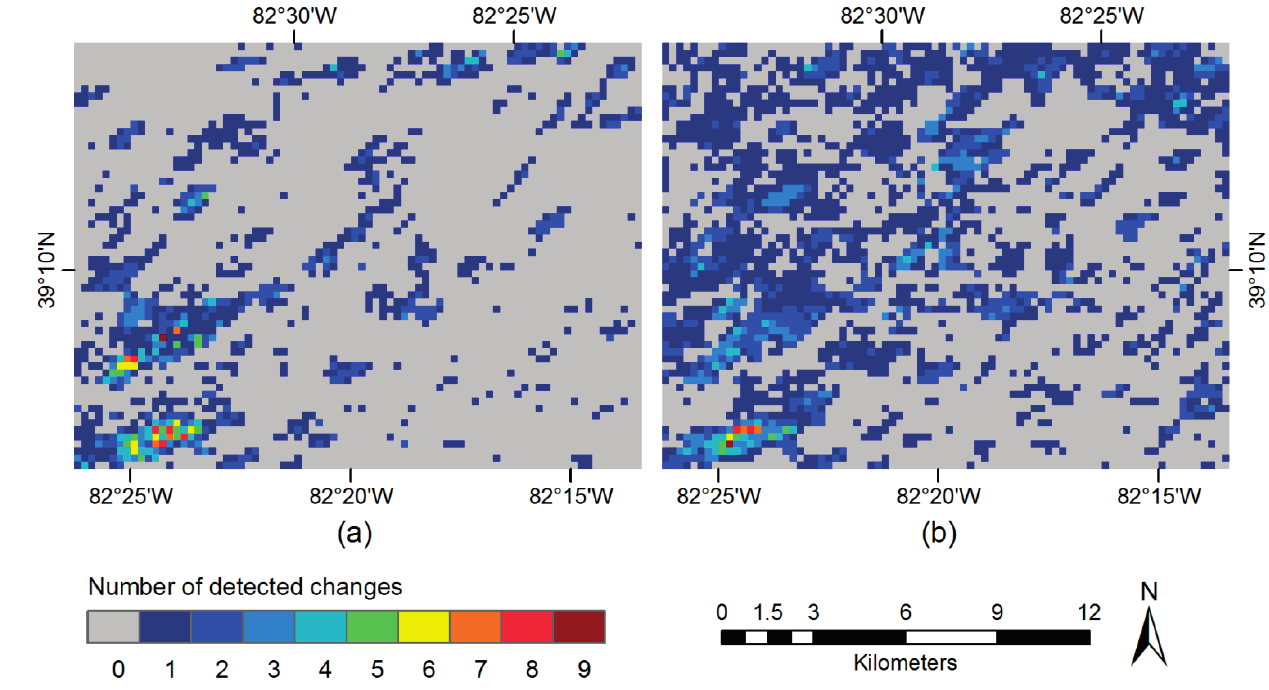
Figure 8. Maps of detected changes from 2000 to 2012 generated by the proposed method ( a ) and BFAST ( b ). The extent of the map corresponds to the sub-area as shown in Figure 1. The color of a pixel is coded by its value according to the color bar on the bottom left. The pixel values equal the number of detected changes during the entire time